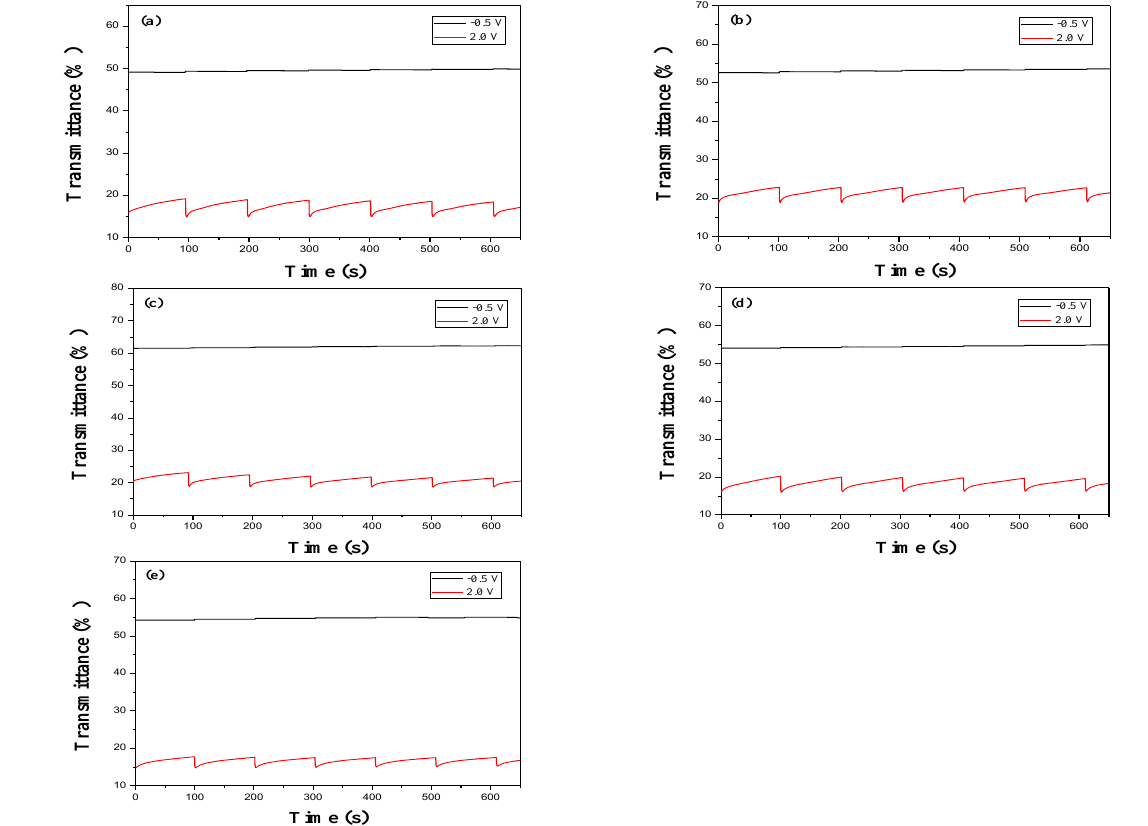
Figure 9. Open circuit stability of ( a ) PDTC/PEDOT-PSS, ( b ) P(DTC- co -BTP)/PEDOT-PSS, ( c ) P(DTC- co -BTP2)/PEDOT-PSS, ( d ) P(DTC- co -TF)/PEDOT-PSS, and ( e ) P(DTC- co -TF2)/PEDOT-PSS ECDs.